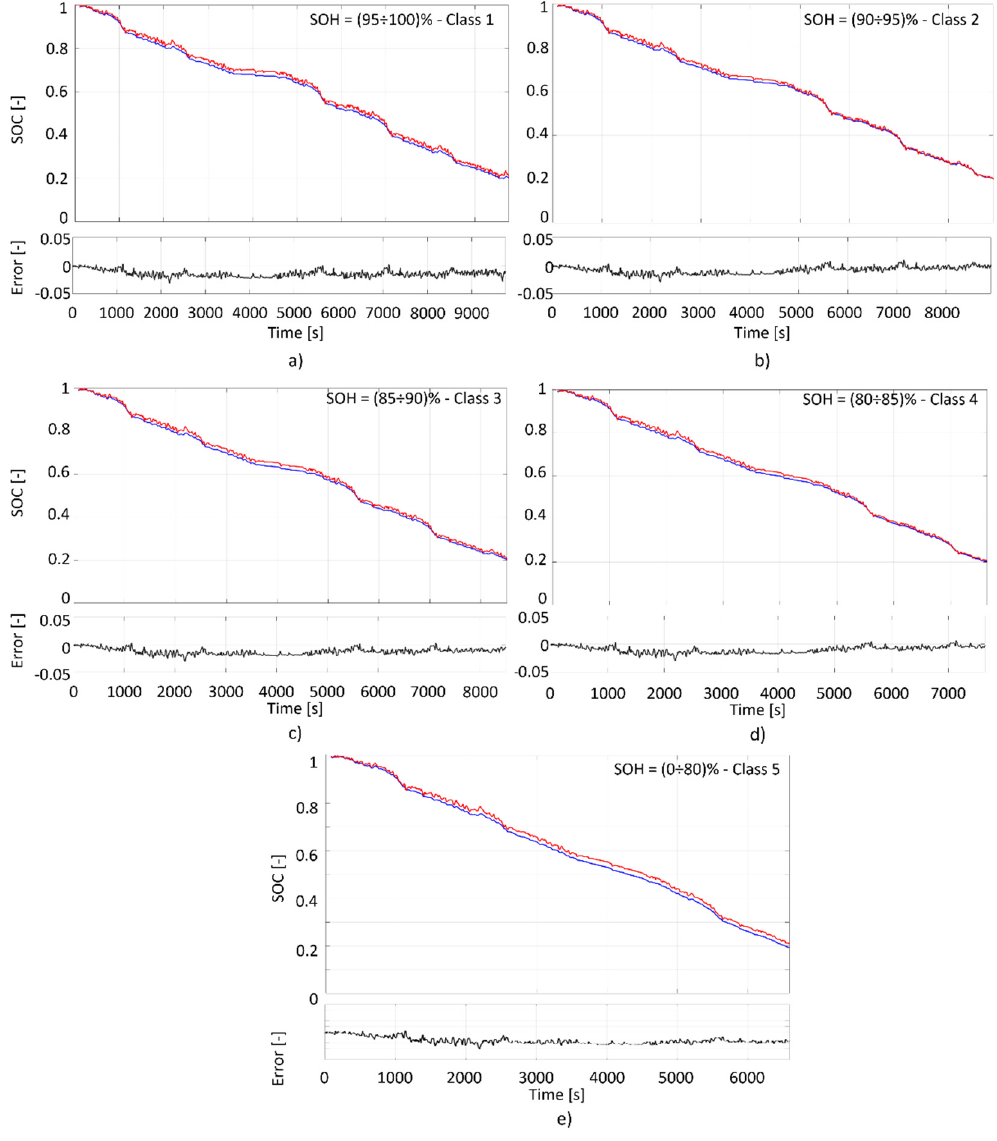
Figure 9. SOC estimation at different degradation levels. Red line: expected value. Blue line: estimation. Error indicates the difference between the estimated and expected values. ( a ): ageing class 1 (SOH: 95 ÷ 100%); ( b ): ageing class 2 (SOH: 90 ÷ 95%); ( c ): ageing class 3 (SOH: 85 ÷ 90%); ( d ): ageing class 4 (SOH: 80 ÷ 85%); ( e ): ageing class 5 (SOH: 0 ÷ 80%).